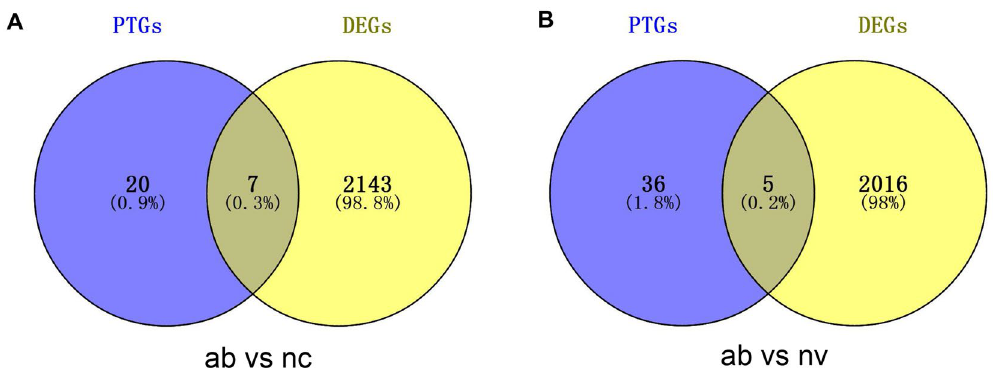
Figure 7. Numbers of DELs and DEGs in different groups. ab: the ab group; nc: the nc group; nv: the nv group. ( A ) Venny of DELs and DEGs between the ab group and the nc group; ( B ) Venny of DELs and DEGs between the ab group and the nv